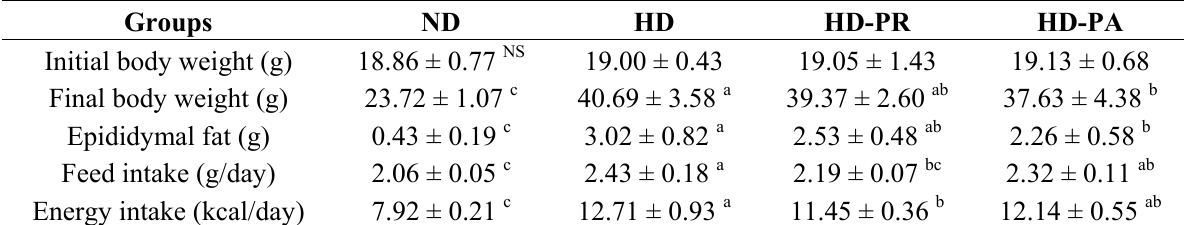
Table 2. Body weight, epididymal fat, food intake and energy